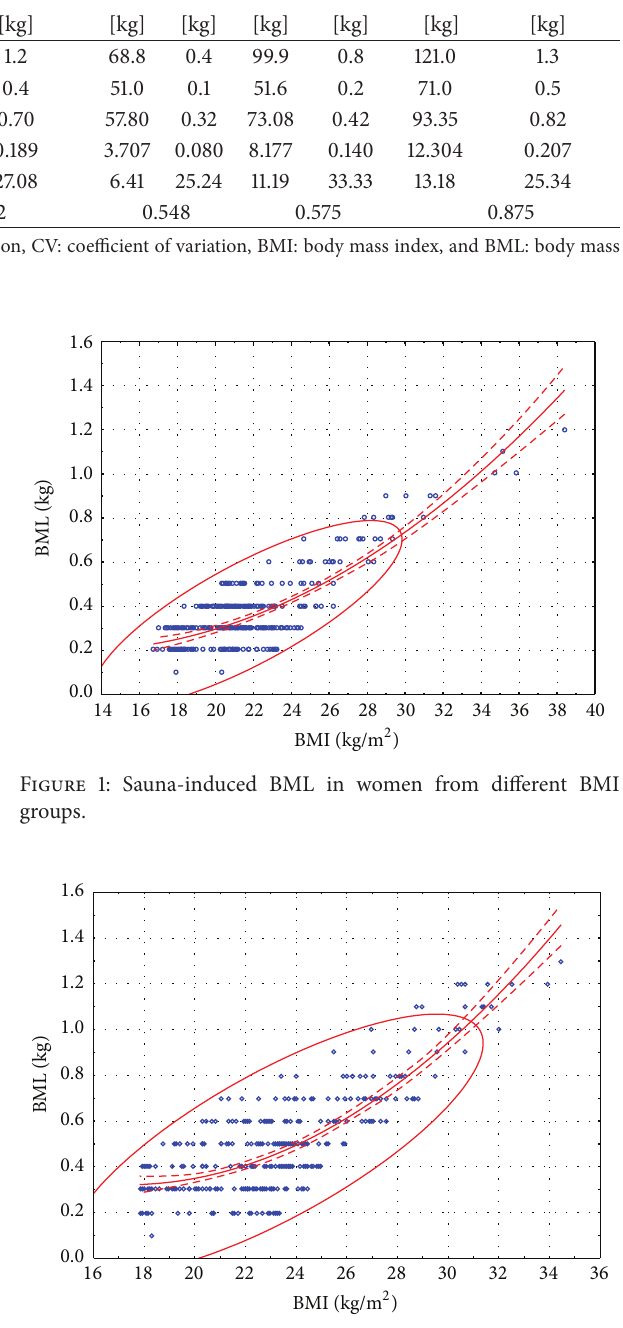
Statistical parameter